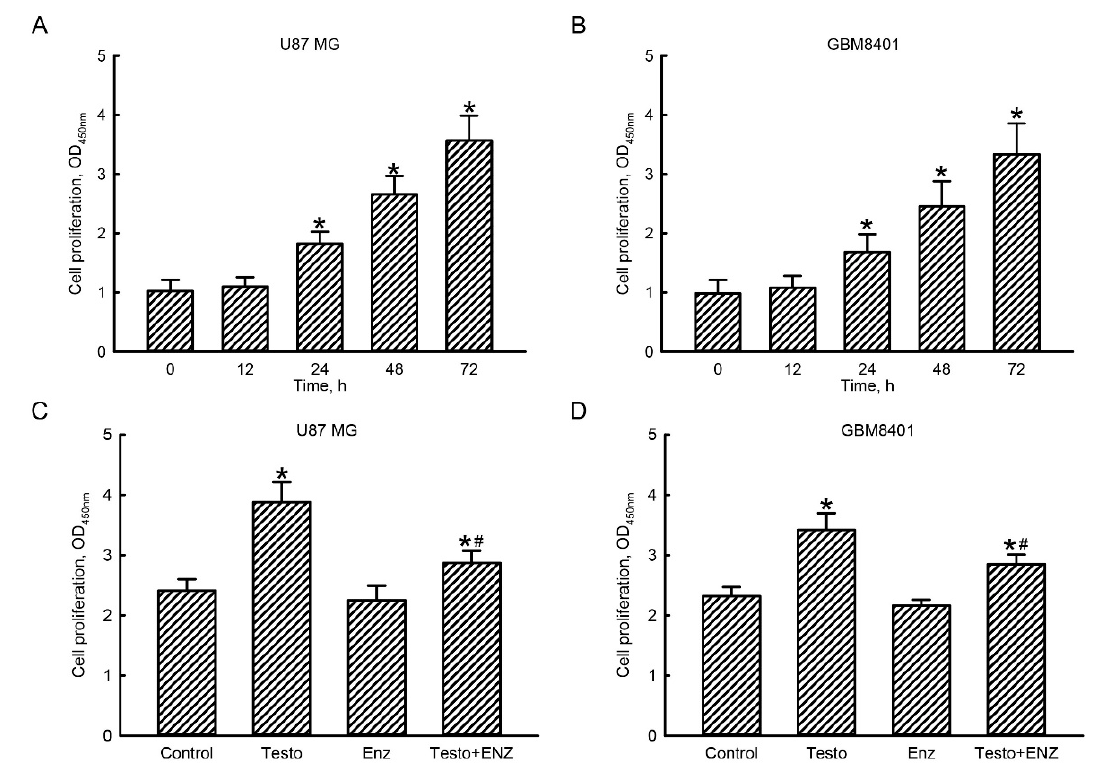
Figure 5. Participation of the testosterone (testo) androgen receptor (AR) signaling axis in proliferation of human glioblastoma cells. Human U87 MG ( A ) and GBM8401 ( B ) glioblastoma cells were treated with 100 nM testo for 12, 24, 48, and 72 h. Human U87 MG ( C ) and GBM8401 ( D ) glioblastoma cells were pretreated with 10 µ M enzalutamide (Enz) for 1 h and then exposed to 100 nM testo for 24 h. Proliferation of human glioblastoma cells was assayed using a colorimetric WST-1 method. Each value represents the mean ± standard error of the mean for n = 6. The symbols * and # indicate that values significantly ( p < 0.05) differed from the control and testo-treated groups, respectively.